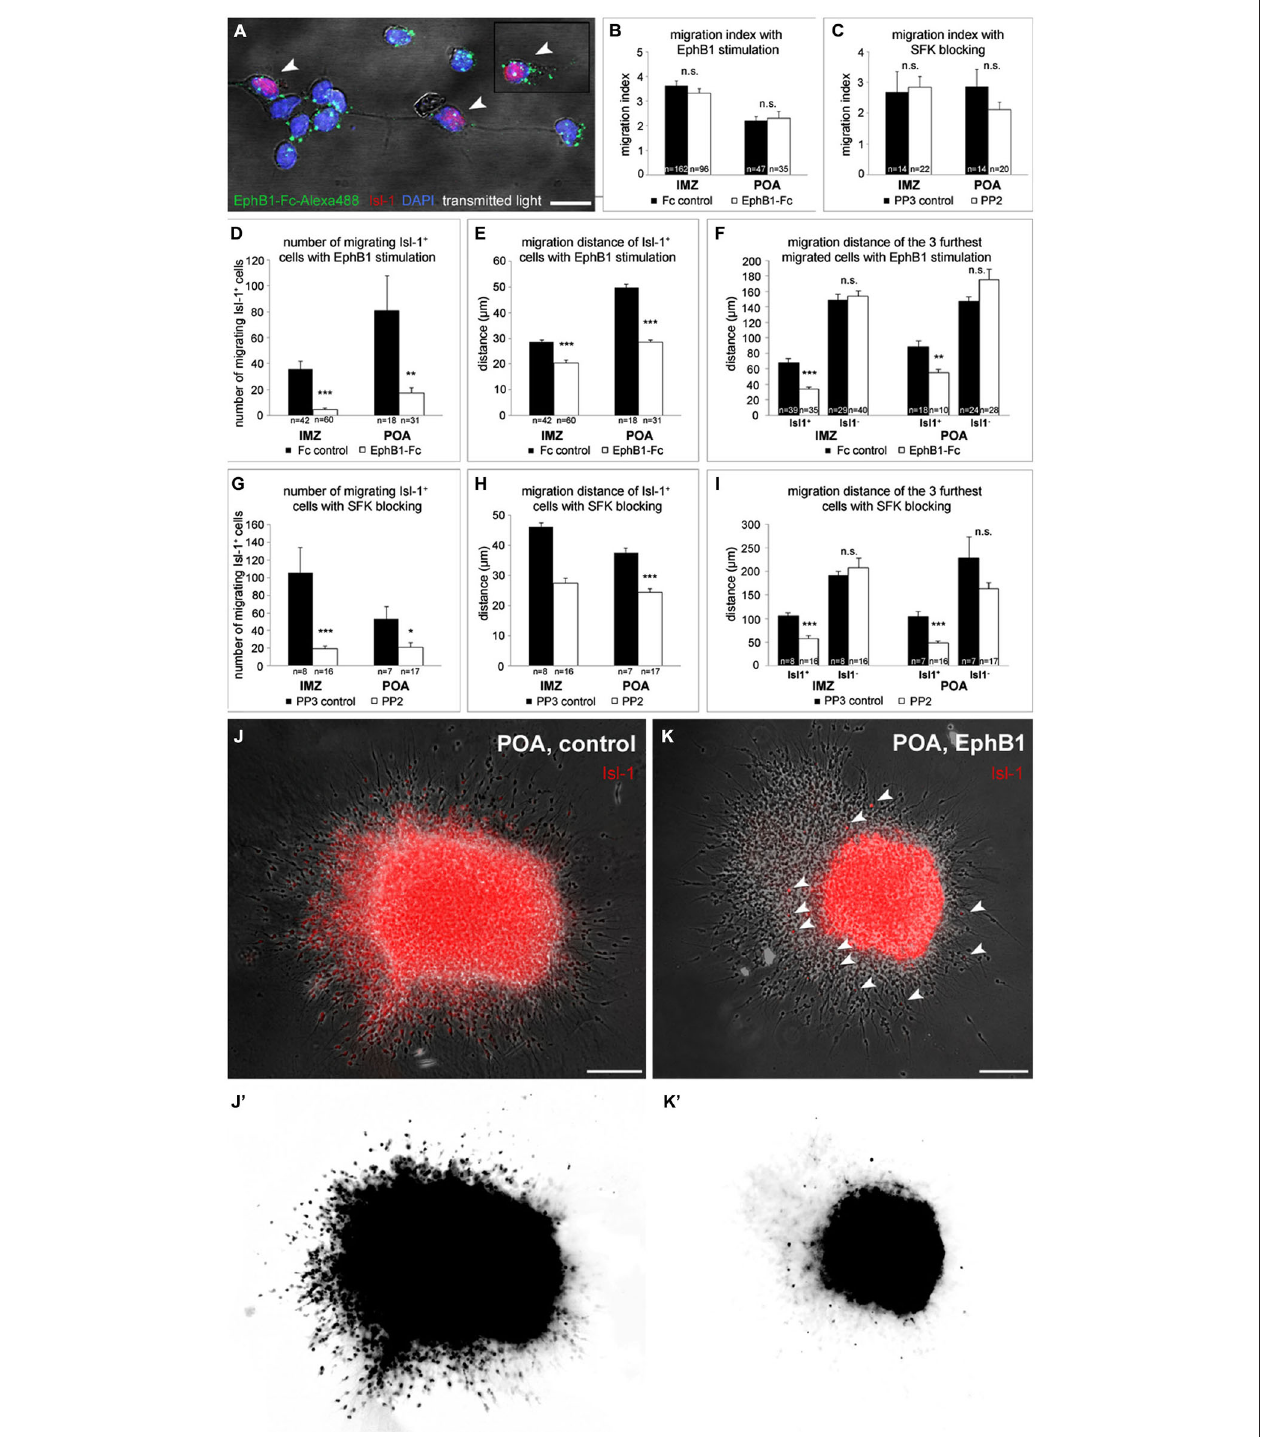
the distance of the three furthest migrated cells ( F,I ) of IMZ- and POA-derived explants, respectively. Explants grew out in a three-dimensional substrate after application of EphB1-Fc or under control conditions ( B, D–F ) and with the Src inhibitor PP2 or the control protein PP3 ( C, G–I ), respectively. After ( Continued